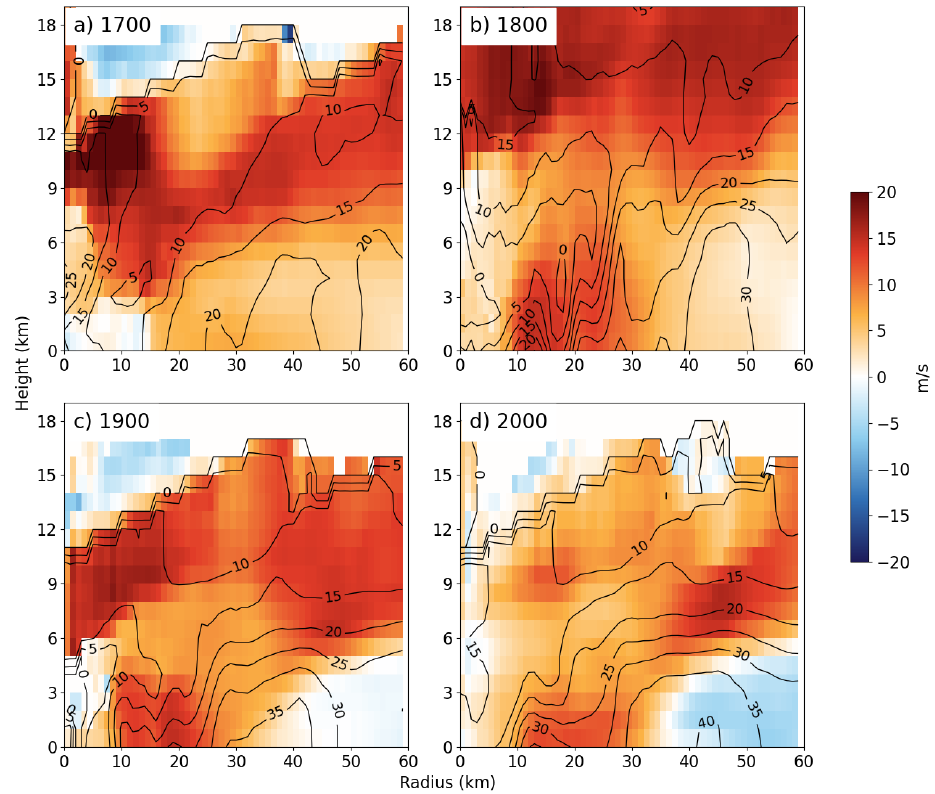
Figure 11. Variations of the radial wind (color shading) and reflectivity (black contour) azimuth means in the downwind of stratiform rainband at 190–240° with horizontal radius of 0–60 km outward from typhoon center with altitude at ( a ) 17:00, ( b ) 18:00, ( c ) 19:00 and ( d ) 20:00 UTC. The negative value of radial wind azimuth mean represents the inflow and the positive value the out- flow.